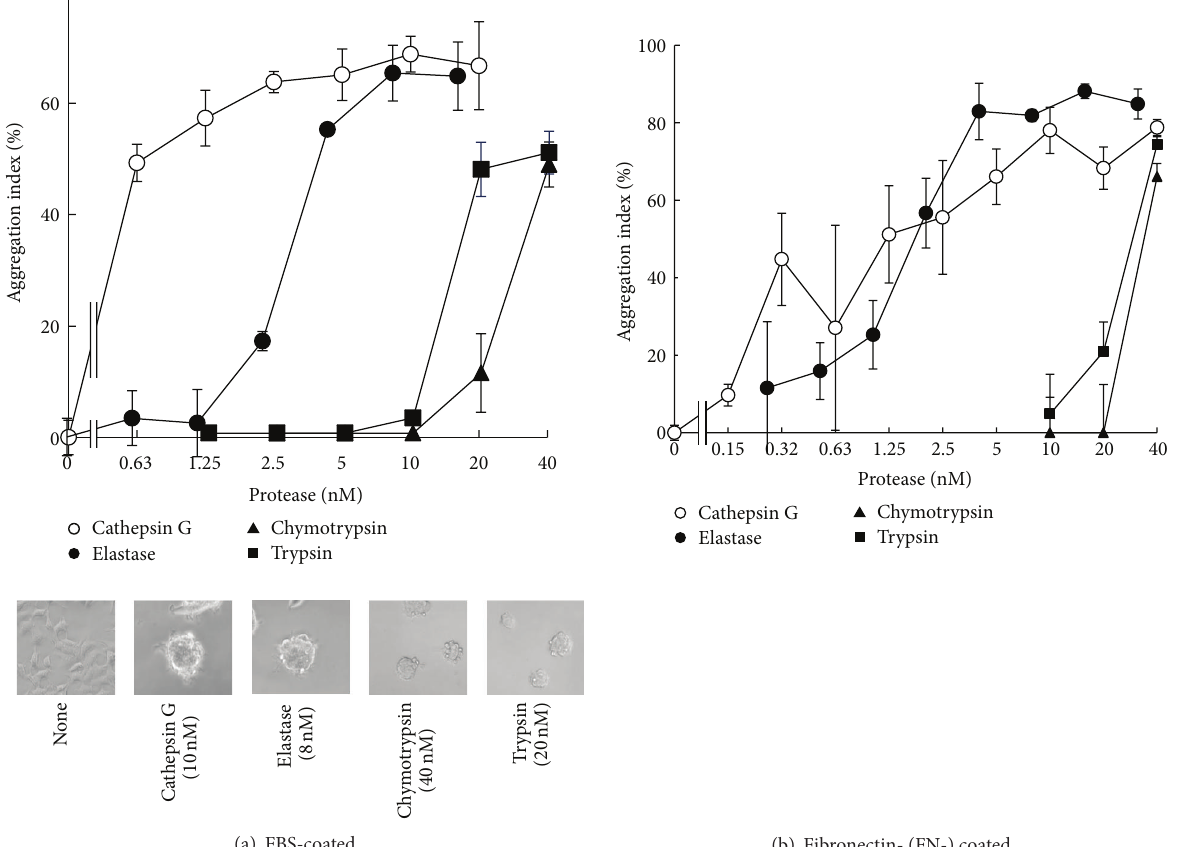
Figure 3: Induction of MCF-7 cell aggregation by serine protease treatment of FBS- or FN-coated wells. FBS-coated wells (a) or FN-coated wells (b) were treated overnight with cathepsin G ( I ), elastase ( e ), chymotrypsin ( 󳵳 ), or trypsin ( ◼ ). Next, MCF-7 cells suspended in 1% BSA-medium were seeded and incubated for 24 h. The cell aggregation index was evaluated as described in the legend of Figure 2. The results are expressed as means ± SD ( 𝑛 = 3 ). When the bars are not shown, they are smaller than the size of the symbols. Lower photos: images of MCF-7 cells at 24h after cultivation in protease-treated FBS-coated wells. Original magnification: × 100.